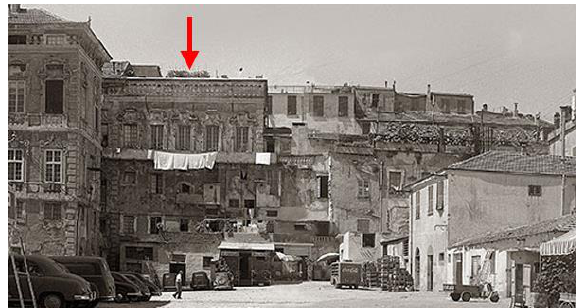
Figure 4. Photo archive Moreschi, Sanremo. Piazza Borea, 1950.